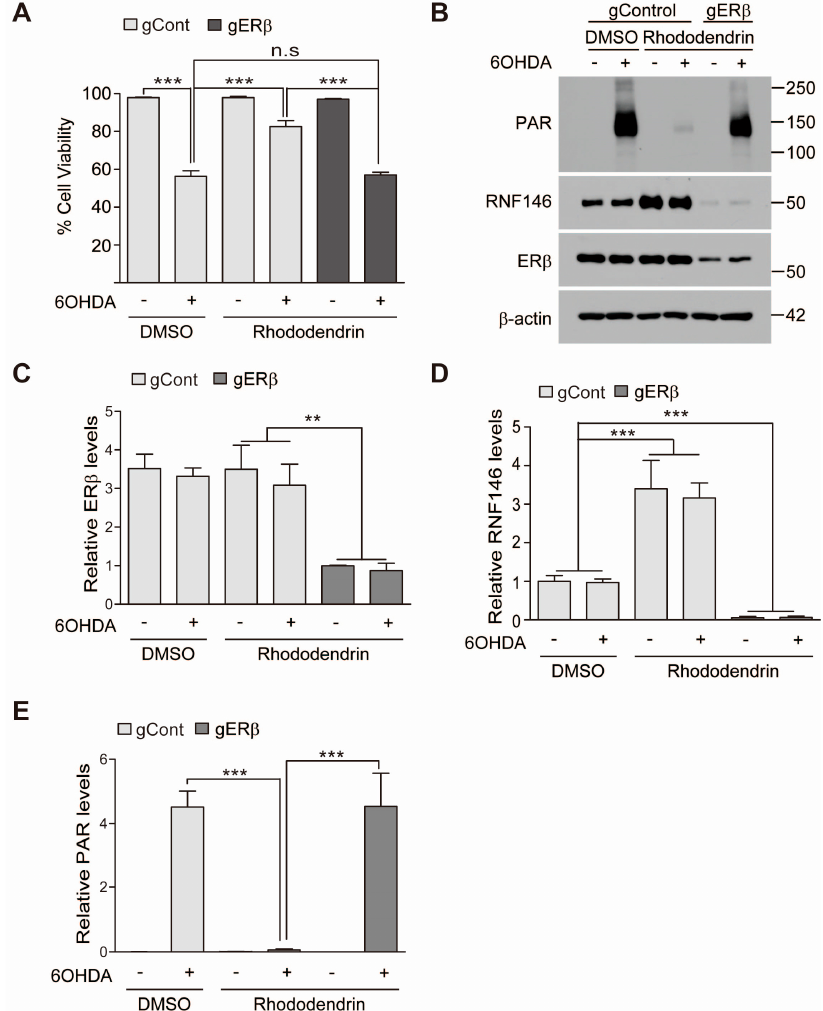
Figure 4. Rhododendrin prevents 6-OHDA cell toxicity via ER β activation. ( A ) Assessment of cell viability in SH-SY5Y cells transfected with CRISPR-cas9 construct targeting ER β (85 h) and subsequently treated with rhododendrin (10 µ M, 37 h) or DMSO as control determined by a trypan blue exclusion assay. Oxidative stress induced cell death was induced by treatment with 6-OHDA (70 µ M, 16 h) ( n = 6). ( B ) Representative Western blot of PAR, RNF146, and ER β in SH-SY5Y cells with the indicated transfections and treatments. SH-SY5Y cells were transfected with CRISPR-cas9 constructs (85 h) followed by 37 h treatment of DMSO or 10 µ M rhododendrin for RNF146 induction. 6-OHDA (70 µ M) challenge for PAR activation was given for 30 min. Quantification of relative ER β ( C ), RNF146 ( D ), and PAR-conjugated proteins ( E ) expression levels in the experimental groups in panel B. Values are normalized to those of β -actin ( n = 3). Quantified data are expressed as mean ± SEM. Statistical significance was determined by ANOVA test with Tukey’s post-hoc analysis, ** p < 0.01, and *** p < 0.001.